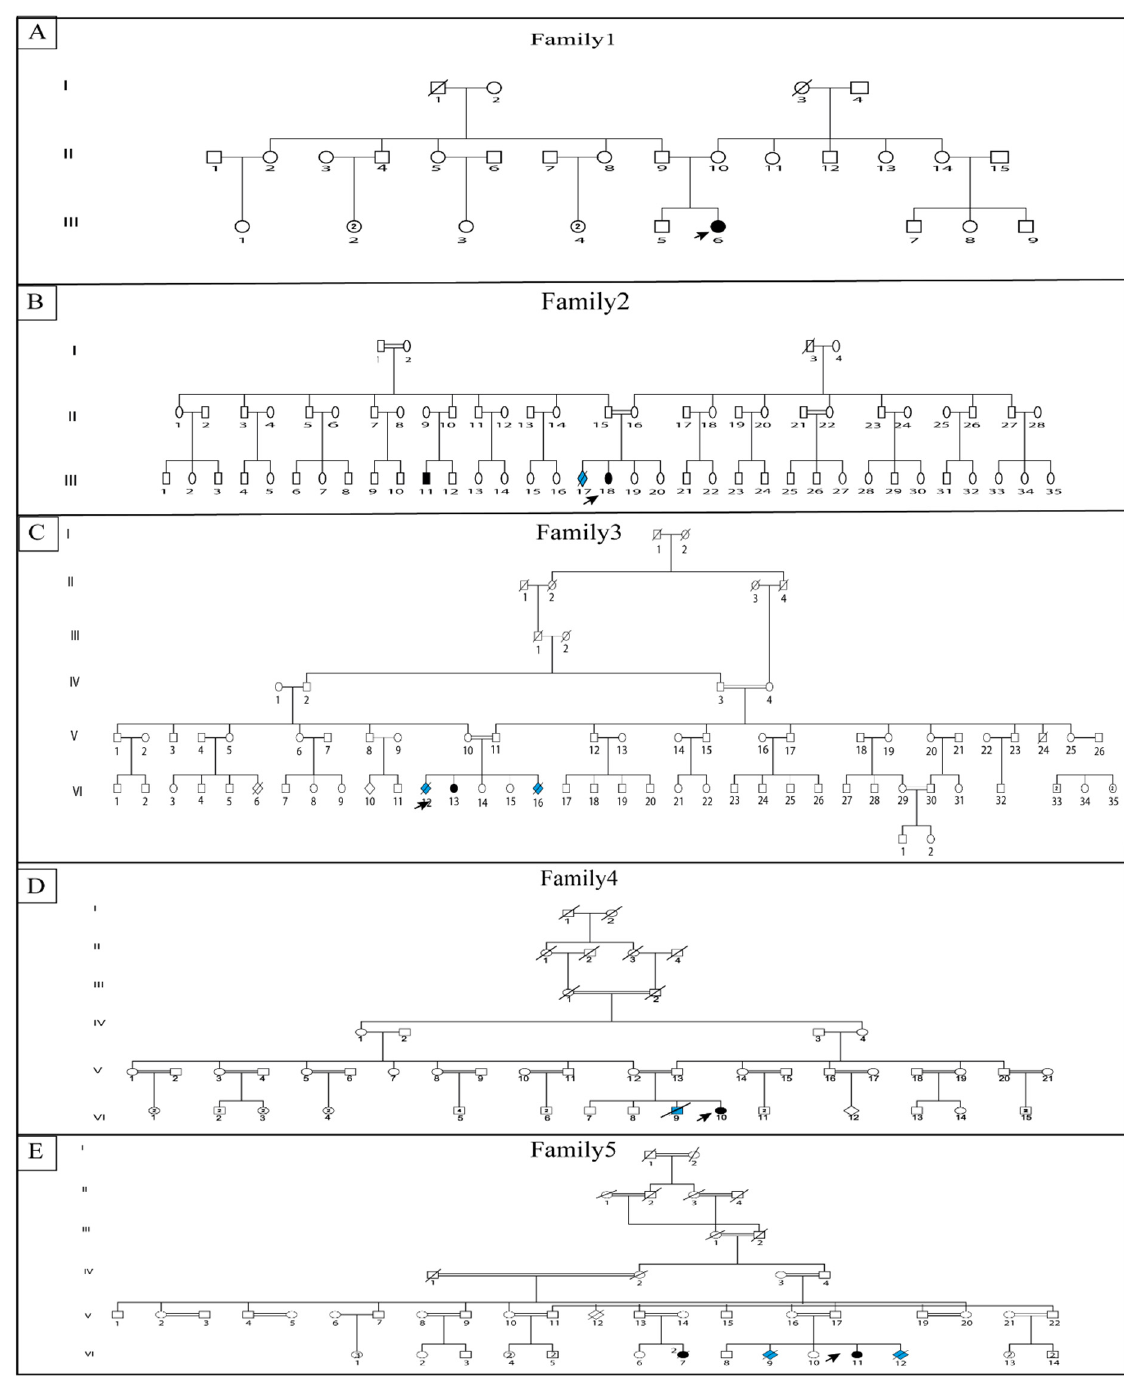
Figure 2. Pedigree describing affected Escobar family members ( A – E ) describe the five studied families. Filled symbols represent affected individual; arrows represent proband; blue filled symbols represent possible diseased individuals related to LMPS open symbols represent unaffected individuals, each generation is labelled I, II from the oldest to the most recent.